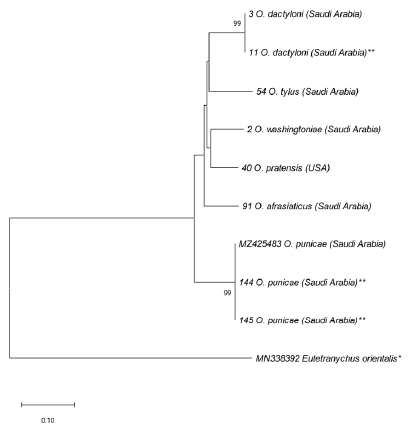
Figure 4. NJ phylogenetic tree based on 10 COI sequences, representing different samples of six Oligonychus species. Eutetranychus orientalis * was retrieved from GenBank and used as an outgroup taxon. A total of eight sequences were obtained in the present study from different hosts and regions in Saudi Arabia, and one from USA (** including samples that have not been identified morpholog- ically till species due to the absence of males). One sequence of O. punicae was retrieved from Gen- Bank, previously reported from Saudi Arabia [7]. Numbers on tree branches are bootstrap values obtained from 1000 replicates.